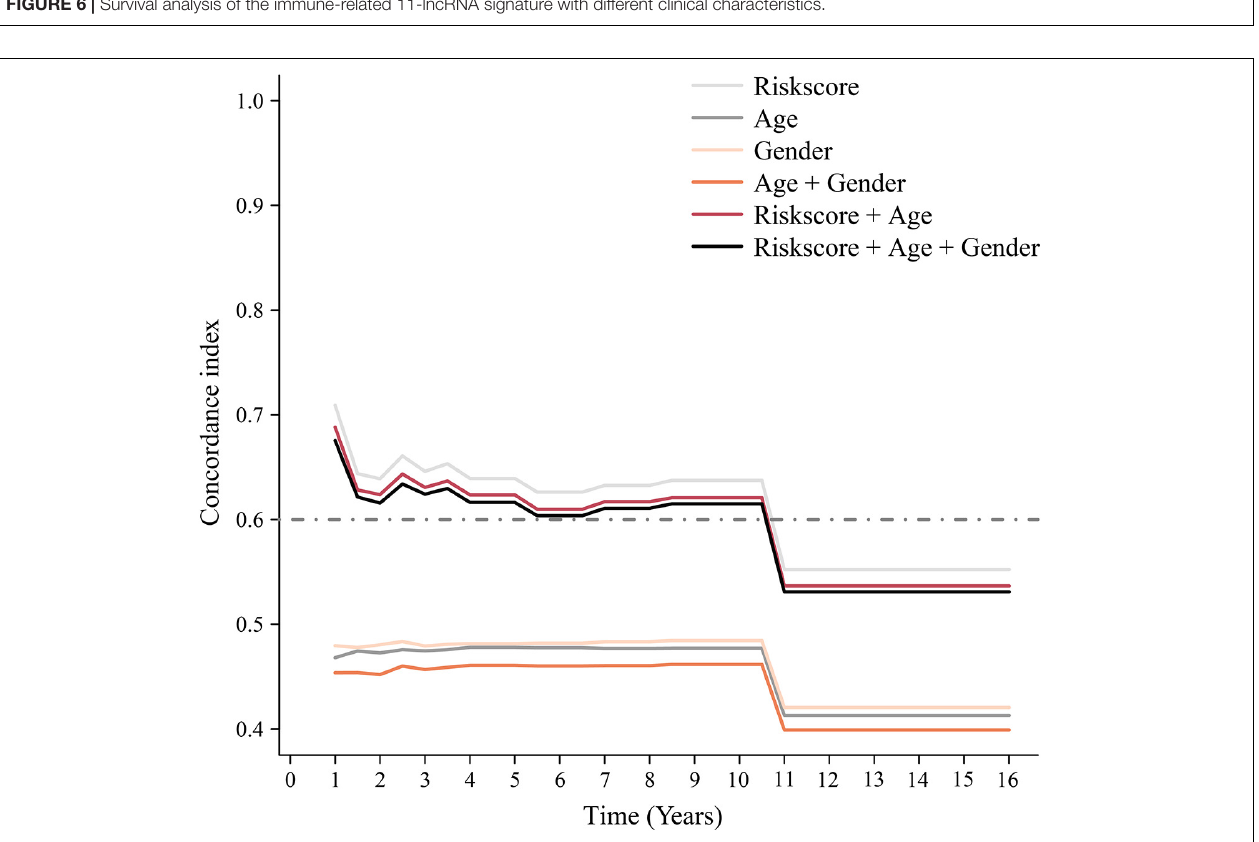
FIGURE 7 | Time-dependent ROC curve. Concordance index (cindex) shows measure of concordance of predictor with survival of patients. The minimum threshold for cindex to be considered effective is 0.6.